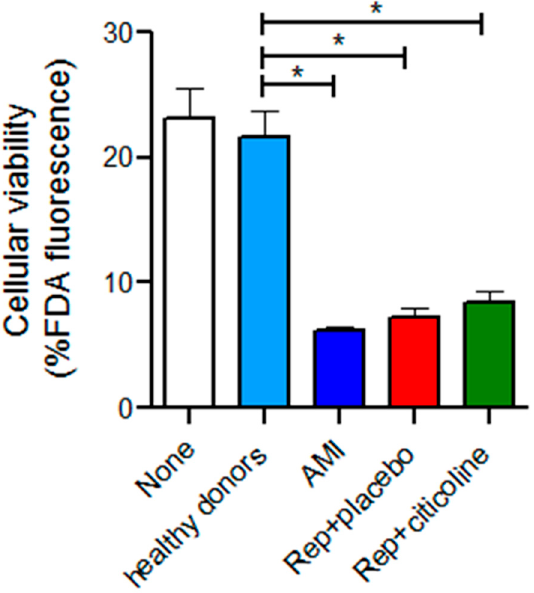
Figure 6. Effect of exosomes obtained from AMI patient plasma subjected to coronary angioplasty and treated with citicoline on cellular viability. Cellular viability was measured with fluorescein diacetate (FDA, n = 9 by duplicate). H9c2 cells exposed to hypoxia and reoxygenation were incubated for 24 h with exosomes from AMI patients and with exosomes from reperfused patients treated with and without citicoline. Results are shown as mean ± SE, * p ≤ 0.05 .